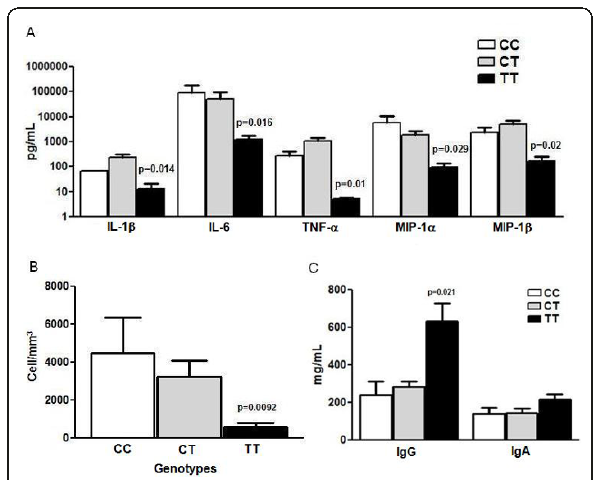
Figure 1 Markers of immune response associated to SNP AADAT +401C/T . a) Cytokine and chemokine concentration in CSF samples of BM patients in relation to the genotype for SNP AADAT +401C/T; b) Cell counts associated to AADAT +401C/T genotype; c)